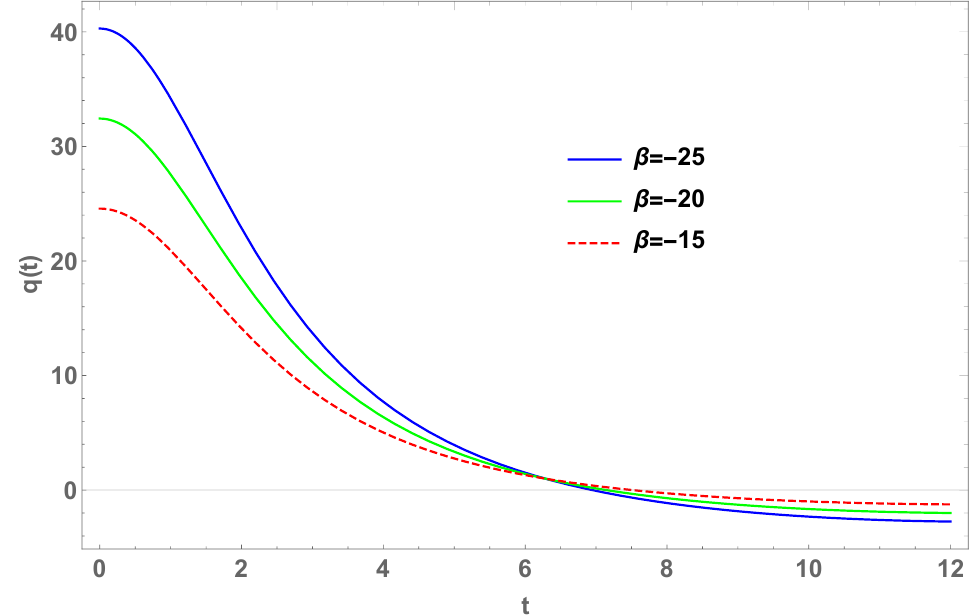
Figure 7. Behaviour of the deceleration parameter ( s ) with respect to cosmic time t for different values of β with γ = 1.65, k =